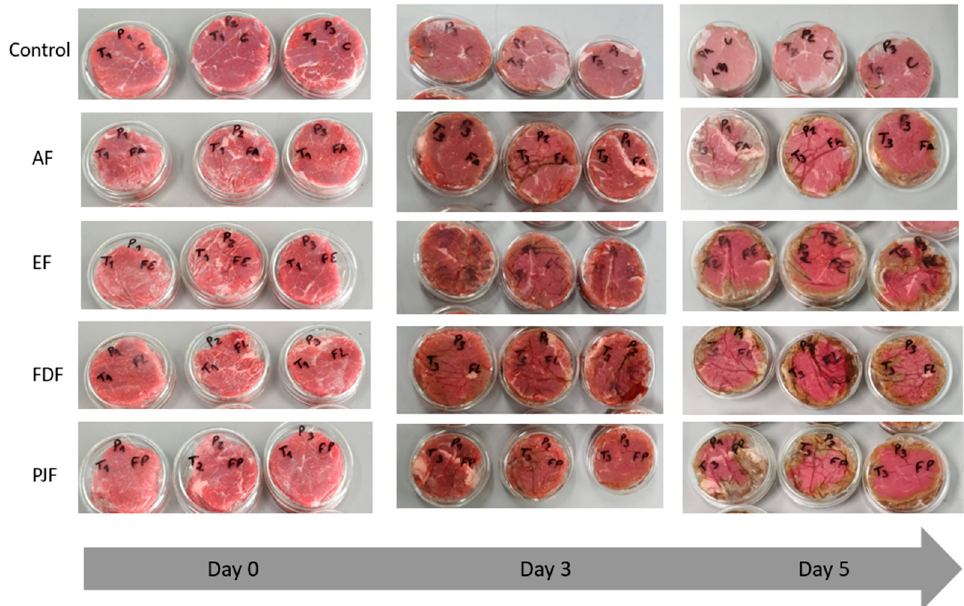
Figure 4. Visual appearance of color meat samples changes during the five days of storage at refrigerated temperature (4 ◦ C). Alginate film with microparticles with encapsulated hydroalcoholic extract (EF), alginate film with pineapple peel juice microparticles (PJF), alginate film with freeze-dried peel powder (FDF), and control films only with alginate (AF).